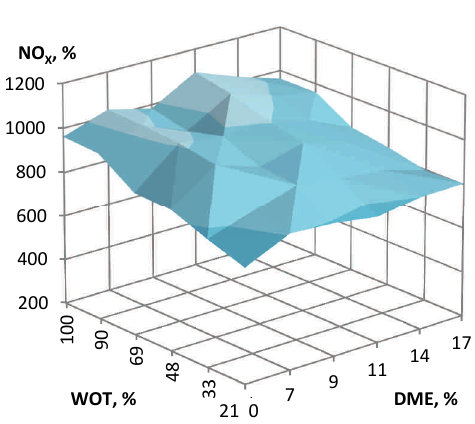
Fig. 18. An influence of DME share & engine load on emission CO, λ = 1.0, n = 2500 rpm